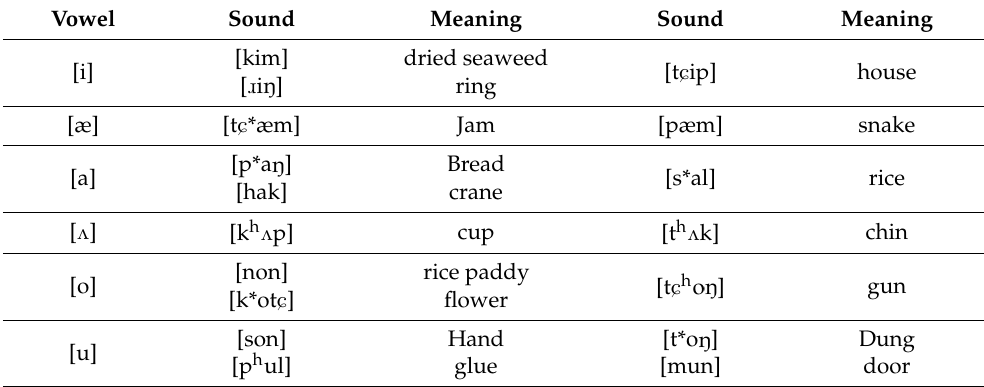
Table 1. List of target words produced by children and perceived by adults.